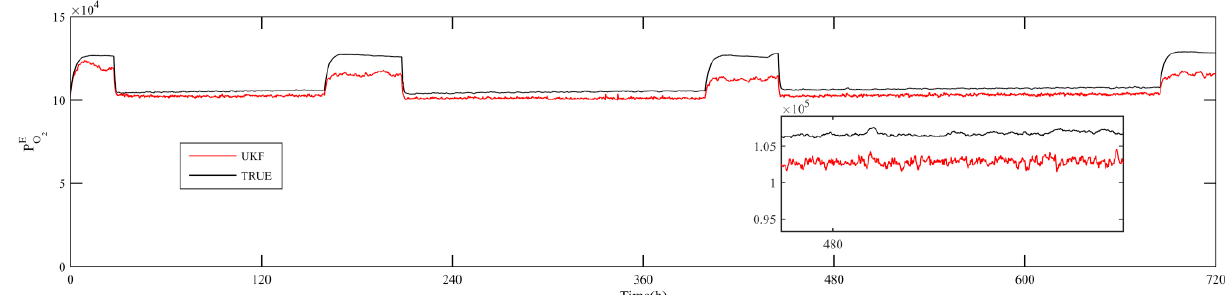
Figure 8. Comparison of true value and estimated value of oxygen partial pressure in cabin.